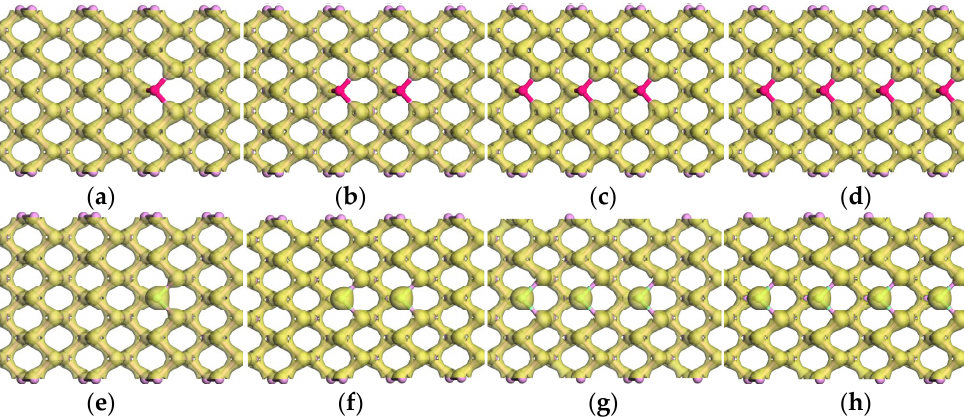
Figure 8. The electron densities (EDs) of doped phosphorenes with different impurity atoms: ( a ) P 63 Al 1 , ( b ) P 62 Al 2 , ( c ) P 61 Al 3 , ( d ) P 60 Al 4 , ( e ) P 63 Al 1 , ( f ) P 62 Cl 2 , ( g ) P 61 Cl 3 , and ( h ) P 60 Cl 4 . The maroon and palegreen balls represent aluminum (Al) and chlorine (Cl) atoms respectively. The value of isosurface is 0.6 e/Å 3 .